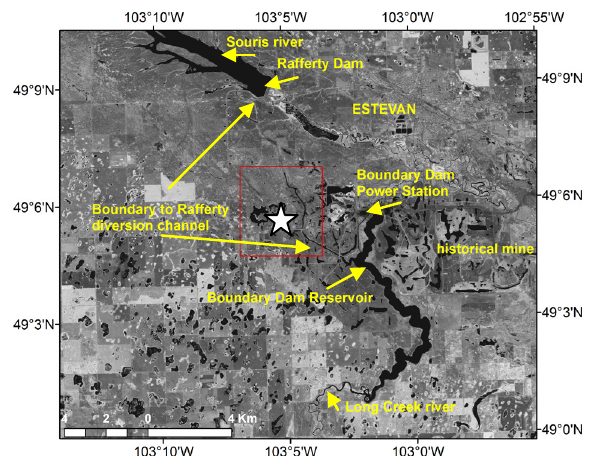
Figure 1. RapidEye satellite image dated 12/08/2012 (DD/MM/YYYY) showing an overview of the Aquistore site marked by red square and surrounding area. Aquistore injection site is marked by star.